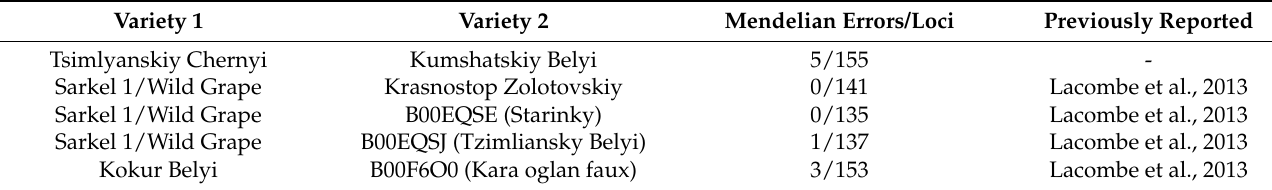
Table 4. Undirected parent–offspring